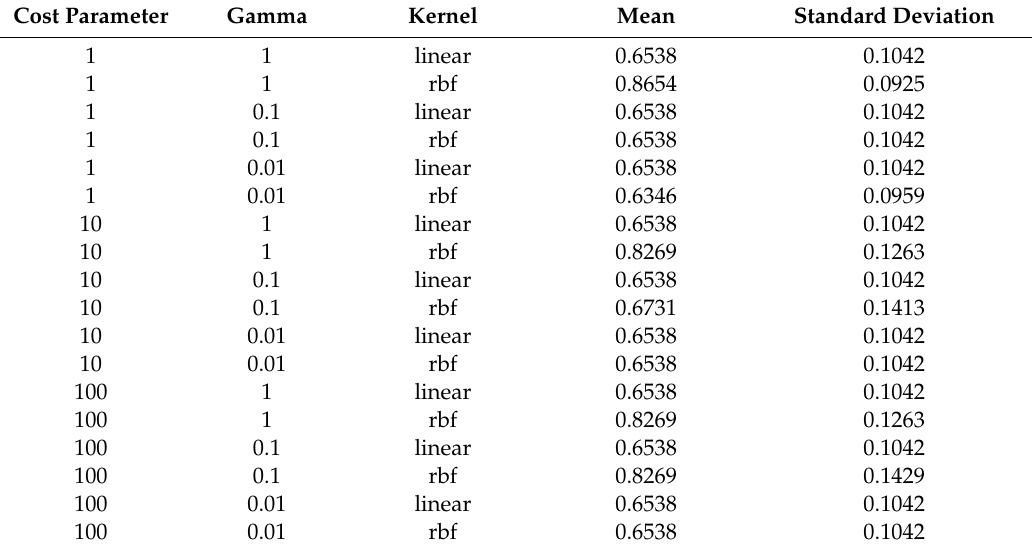
Table 5. Accuracy score and standard deviation of each feature for computer vision method.